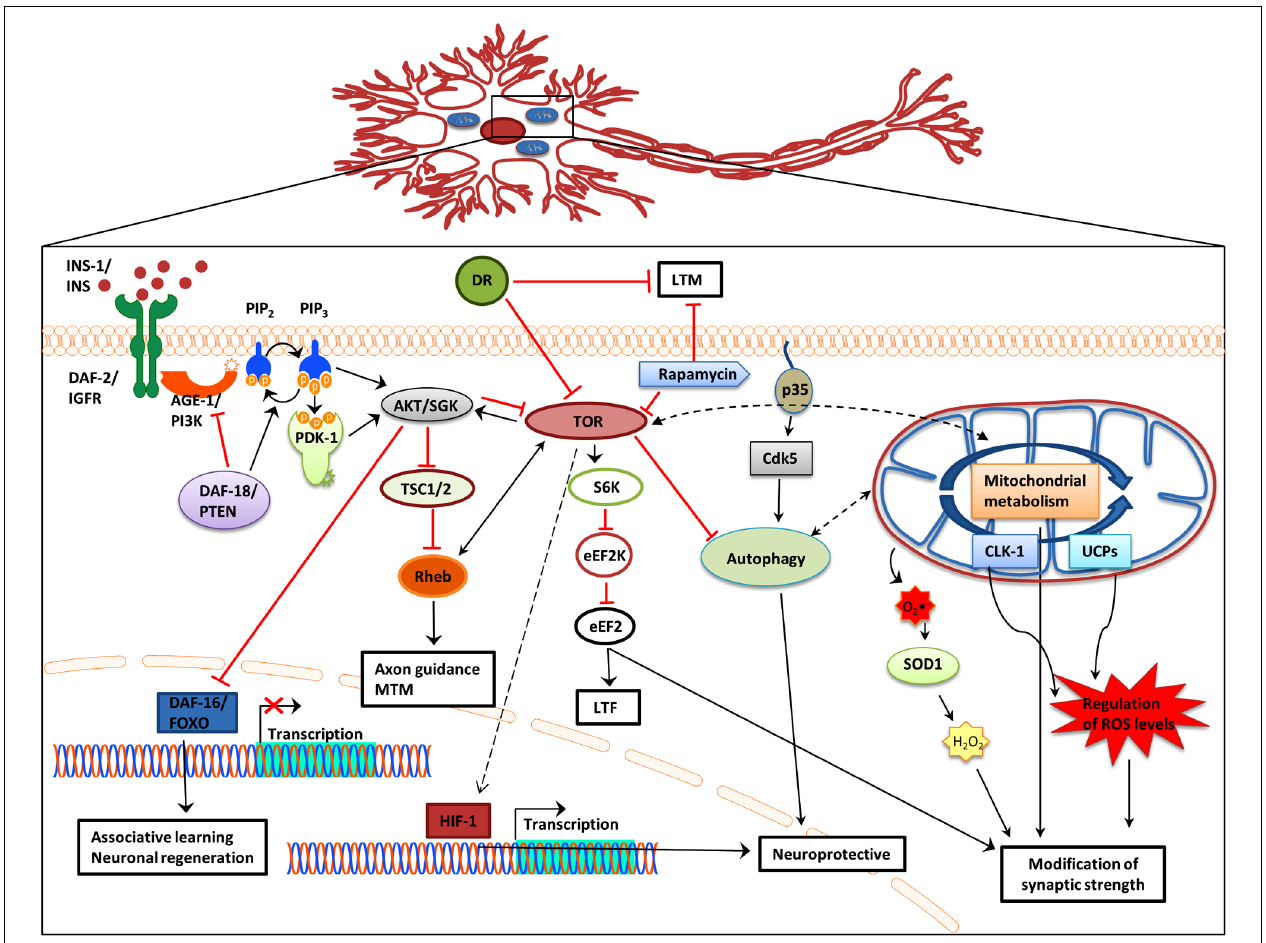
kinase B; Cdk5, cyclin-dependent kinase 5; CLK-1, clock 1; DAF-2/IGFR, insulin-like growth factor receptor; DAF-16/FOXO, forkhead box O; DAF-18/PTEN, phosphatase and ensin homolog; DR, dietary restriction; eEF2, eukaryotic elongation factor 2; eEF2K, eukaryotic elongation factor 2 kinase; HIF-1, hypoxia-induced factor 1; INS, insulin; LTF, long-term facilitation; LTM, long-term memory; MTM, mid-term memory; PDK-1, 3-phosphoinositide-dependent kinase 1; PIP 2 , phosphatidylinositol (4,5)-bisphosphate; PIP 3 , phosphatidylinositol (3,4,5)-trisphosphate; Rheb, Ras homolog enriched in brain; S6K, ribosomal protein S6 kinase; SGK, serum- and glucocorticoid-inducible kinase; SOD1, superoxide dismutase 1; TSC1/2, tuberous sclerosis 1/2;TOR, target of rapamycin; UCPs, uncoupling proteins; Black arrow, direct stimulation; black dashed arrow, indirect stimulation; black dashed double head arrow, interplay; red arrow,